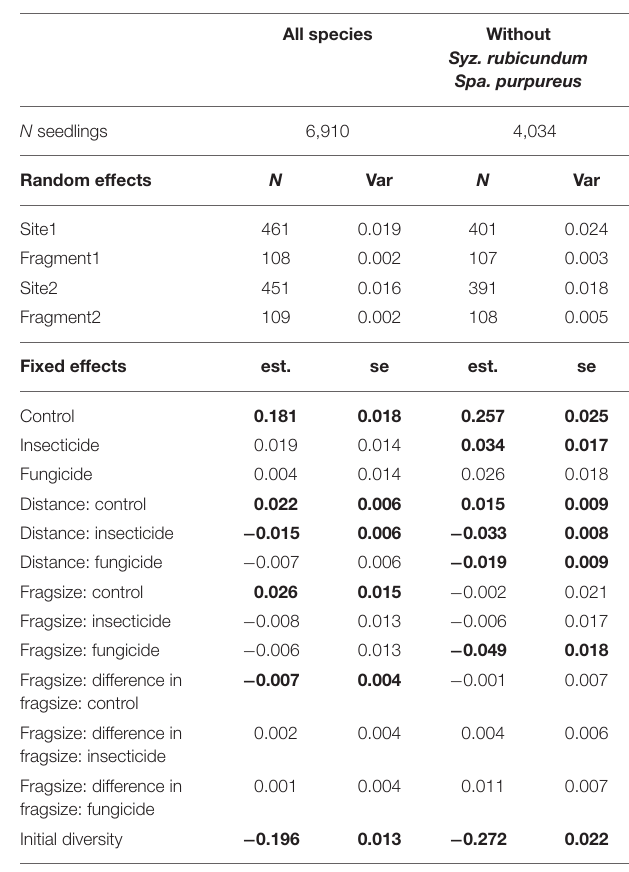
TABLE 2 | Results of linear mixed effects models investigating the influence of experimental treatment, geographic distance between plots, mean pairwise fragment size, and the difference in pairwise fragment size, on changes in pairwise dissimilarity (standardized Bray-Curtis dissimilarities of seedling assemblages from germination to establishment in 1 m 2 plots).